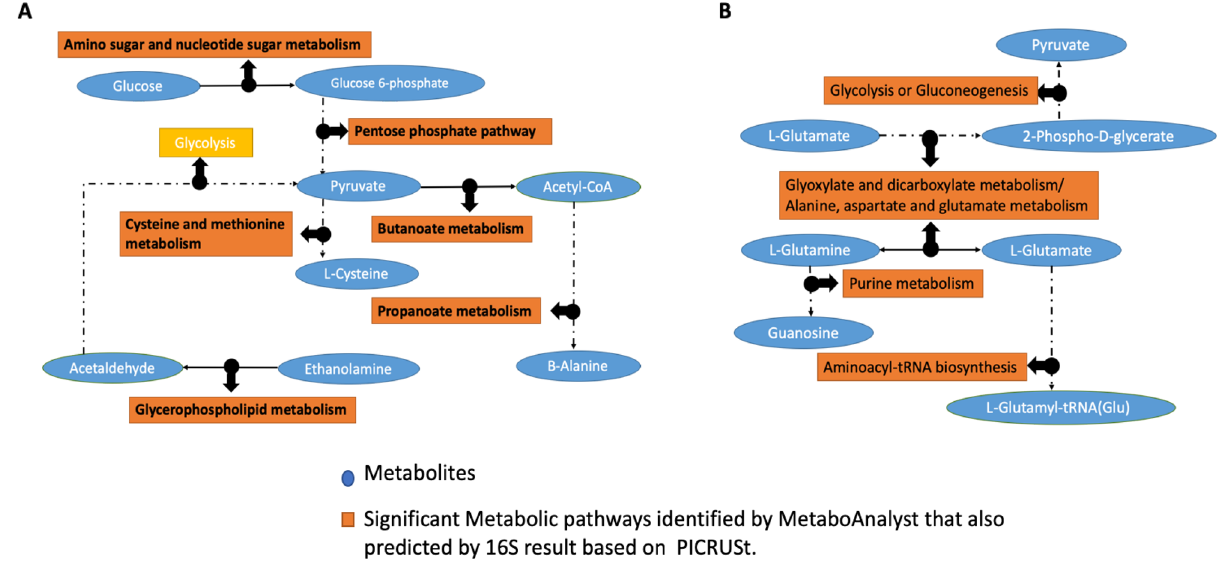
Figure 6. Connections among metabolic pathways that matched with microbial functional prediction result. Females ( A ) and males ( B